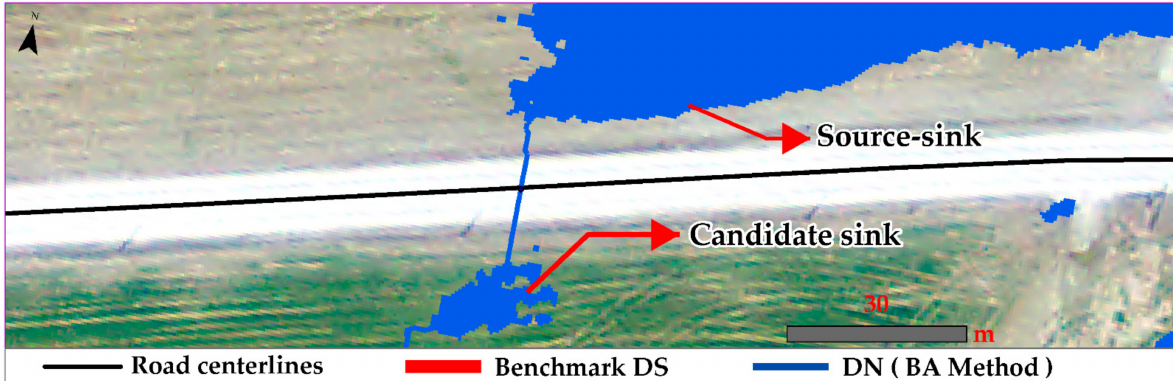
Figure 9. FP cases originating from the culvert-modified DEM obtained using the BA